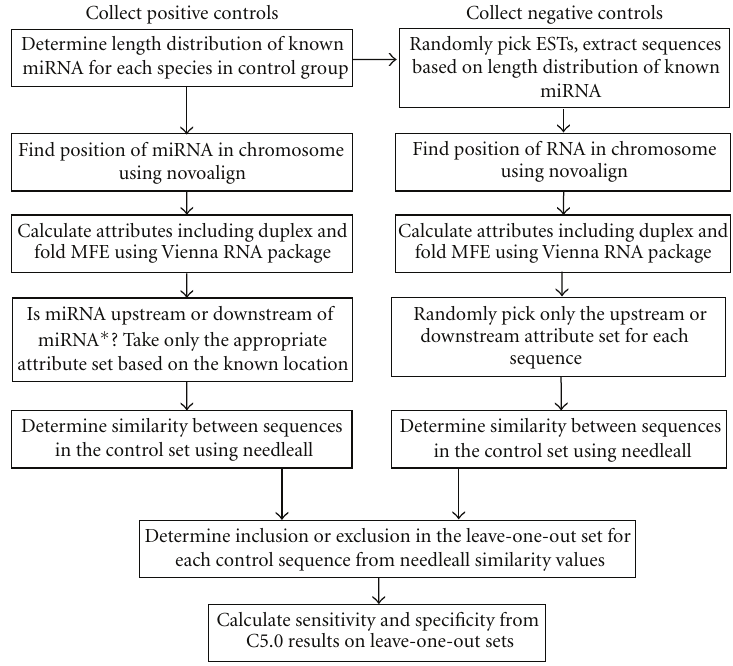
Figure 1: Data processing flow chart for collection of controls, training, and statistical validation. Known miRNAs from miRBase are used as positive controls. Negative controls are randomly picked short segments from ESTs based on the quantity and length distribution of known miRNAs from each plant species in the test set. All controls are aligned to their respective genome. Alignment location allows collection of attributes. For positive controls, the alignment position also allows the location of the miRNA in relation to upstream or downstream of miRNA ∗ to be determined within the precursor. Only attributes from the correct location are valid for training positive controls. Upstream or downstream attributes are equally valid for negative controls, therefore only one is selected at random. Positive controls were aligned using needleall to determine the similarity between all miRNAs. Negative controls were also aligned. The similarity values from the alignment were used to determine if other highly similar sequences should also be excluded when the one in the leave-one-out set was excluded from training. Each sequence in a leave-one-out set was tested for correct classification by the model just trained using controls in the inclusion set. Counts of correct and incorrect classification were used to calculate sensitivity and specificity.